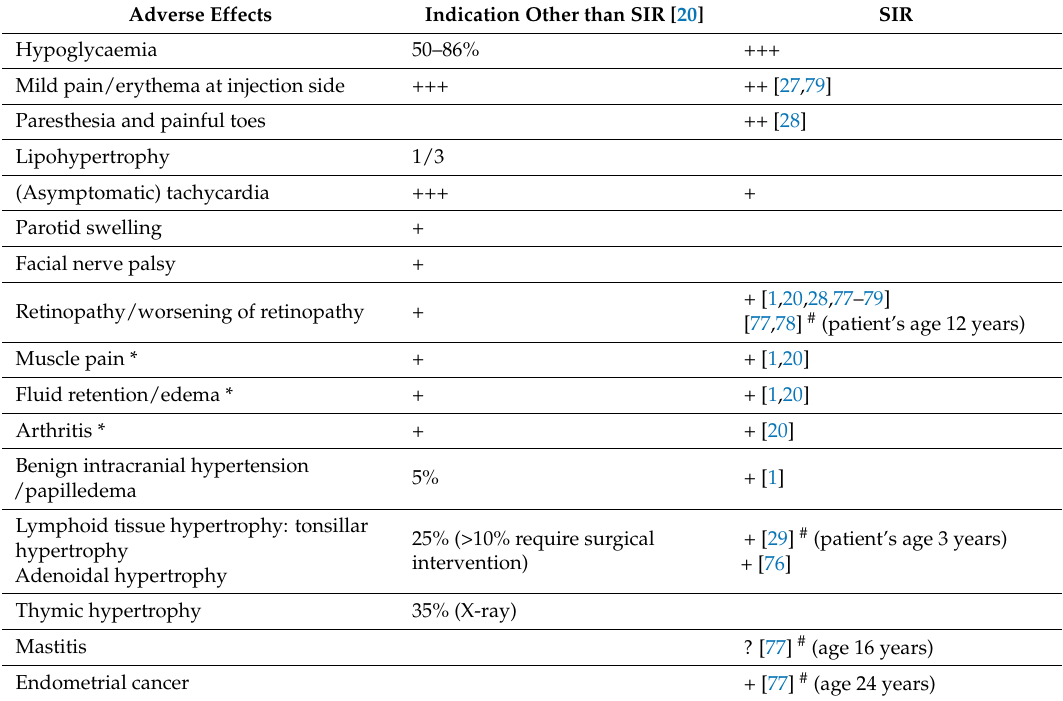
Table 4. Adverse effects of mecasermin treatment in conditions other than SIR and in patients with